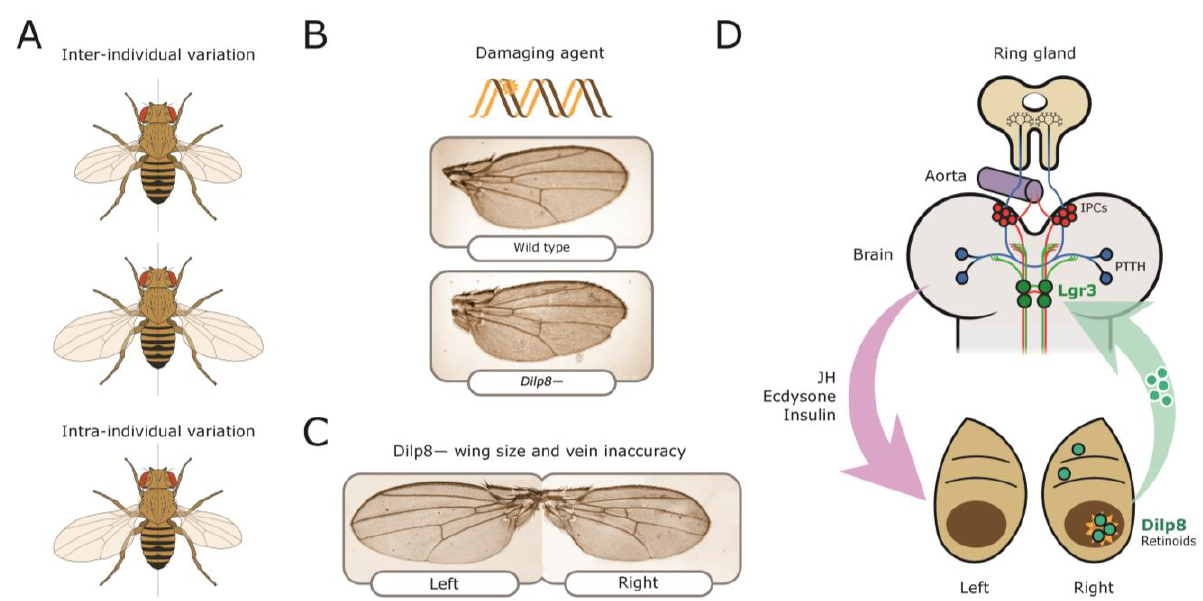
FIGURE 2: Neuroendocrine control of symmetry and body size. (A) Loss of the Dilp8 hormone yields flies with variable body sizes (inter- individual) and increased bilateral asymmetry (intraindividual variability). (B) Feeding Drosophila juveniles with the DNA-damaging agent ethyl methanosulfonate (EMS) induces massive cell death in the imaginal discs, cell cycle arrest, and strong developmental delay. Without dilp8 (bottom wing), EMS-fed animals cannot recover from this damage and exhibit a 6-fold increase in pattern and growth inaccuracies [14]. (C) dilp8 mutants exhibit left-right wing asymmetry and also pattern inaccuracies, which may reflect the unmasking of pre-existing or acquired mutations, stochastic noise, and/or the negative effect of the environment (e.g., temperature stress). (D) Dilp8 produced by damaged or growth-perturbed cells, which also activates the production of other ‘alarm’ signals such as retinoid signals [145] is released to circulation and acts in the brain through the relaxin receptor Lgr3 (green neurons). Lgr3 co-regulates two neuronal populations which control growth and maturation rate by acting on the ring gland. The ring gland is a central neuroendocrine organ regulating organismal growth rate and timing of maturation [45]. Distinct groups of cells within the ring gland — the corpus allatum — produce the juvenile hormone (JH), and cells of the prothoracic gland synthesise and release the steroid hormone ecdysone. Its complex functions are centrally controlled by neurons that produce the prothoracicotropic hormone (PTTH; represented as blue circles) [139,146] and the insulin-producing cells (IPCs; red circles). IPCs produce insulin-like peptides, primarily Dilp2, Dilp3, and Dilp5, and regulate systemic growth and ecdysone biosynthesis (reviewed in